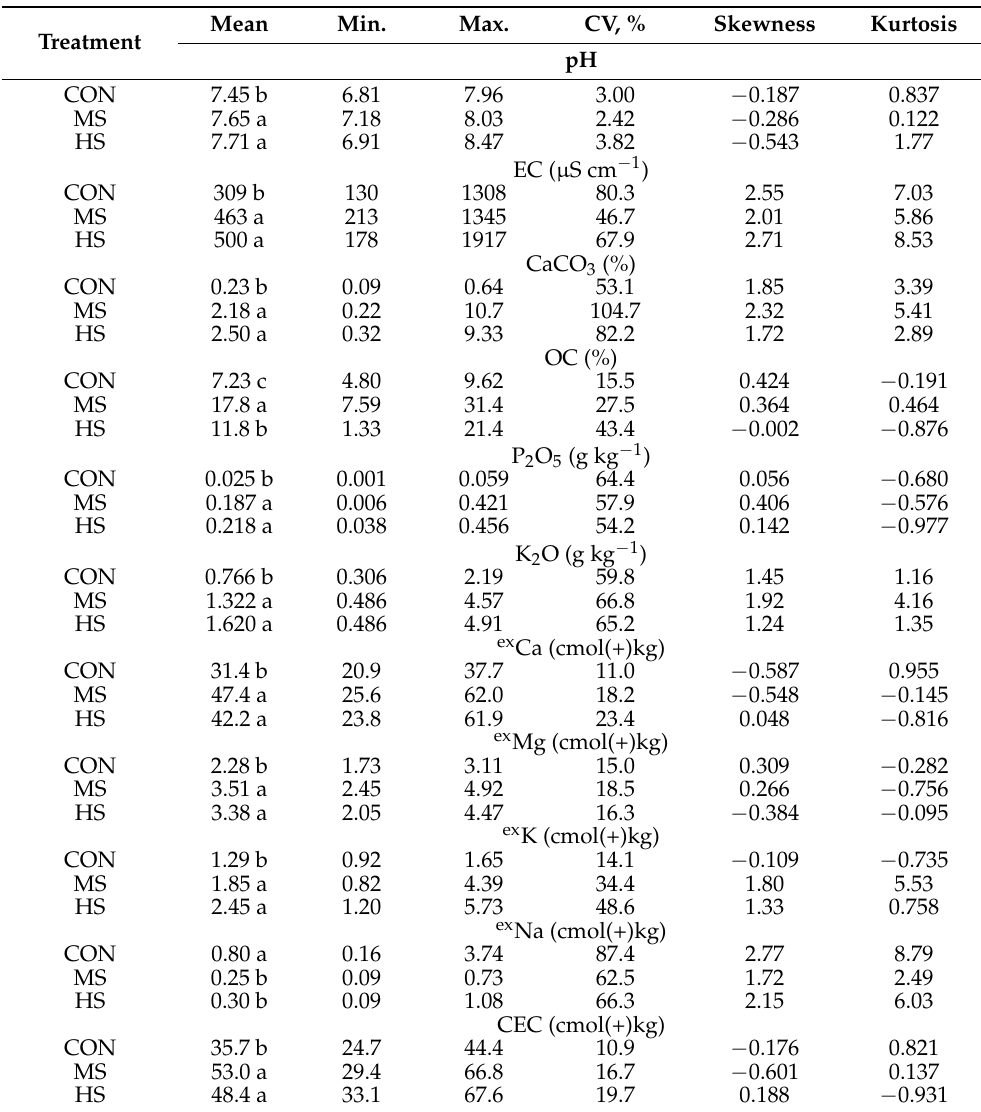
Table 2. Descriptive statistics of soil properties within one year after the wildfire. Abbreviations: unburned control (CON); moderate fire severity (MS); high fire severity (HS). Different letters represent significant differences at a p < 0.05. ( n = 120).